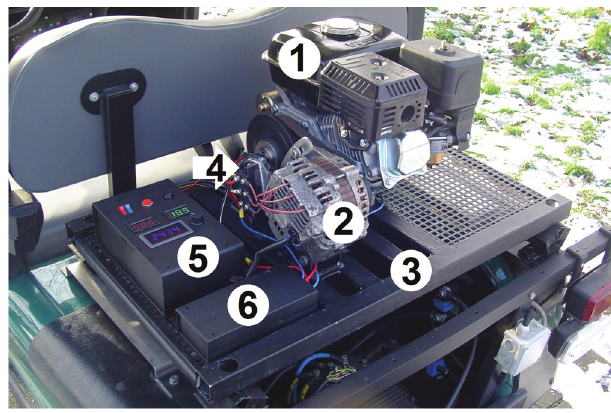
Fig. 5. View of the developed 48 V range extender: 1 – engine, 2 – gener- ator, 3 – support frame, 4 – rectifier bridge, 5 – generator control unit, 6 – relays and voltage converter for a starter